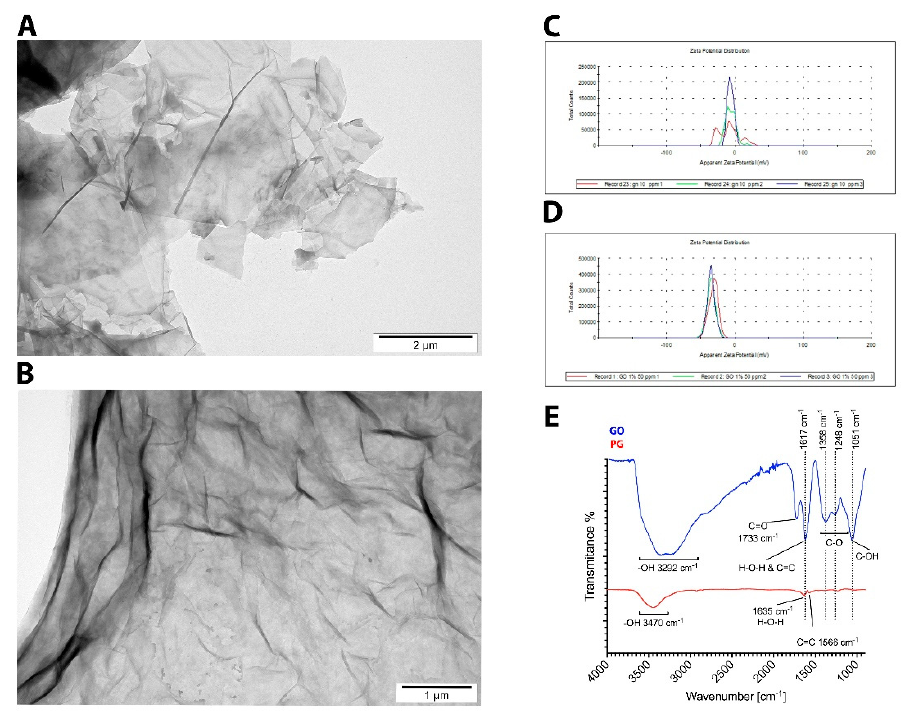
Figure 1. Physicochemical characteristics of the PG and GO: TEM images of agglomerated PG ( A ) and GO ( B ) flakes; zeta potential of PG ( C ) and GO ( D ); FT-IR (ATR, attenuated total reflectance) spectrum of PG and GO ( E ).